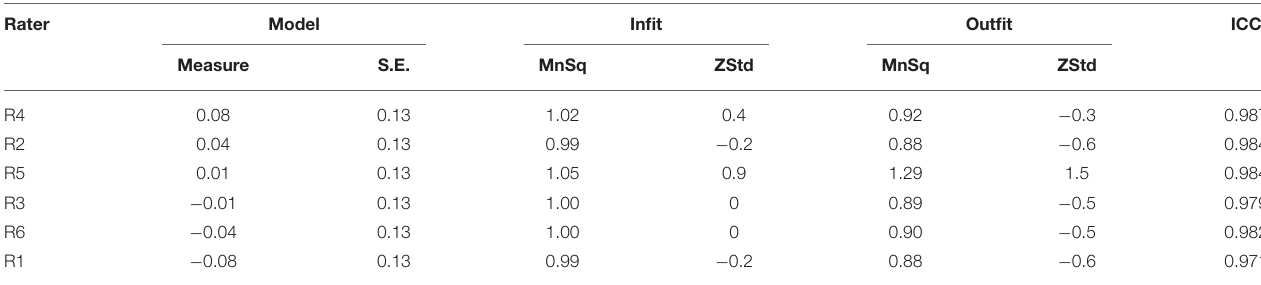
TABLE 2 | The results of the inter-rater reliability and retest reliability.